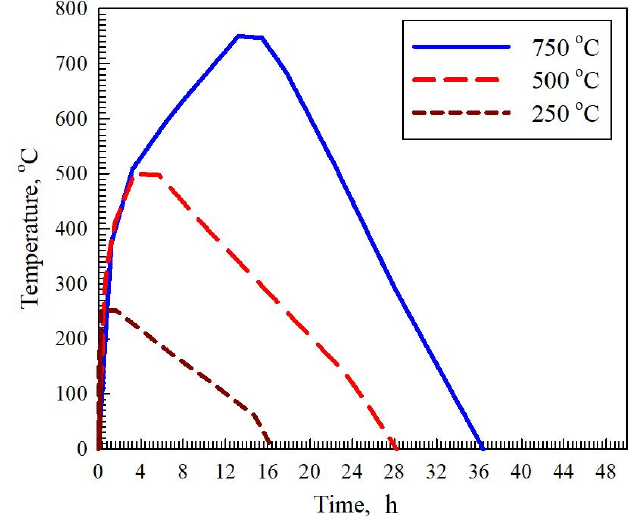
Figure 2. The time–temperature schedule.